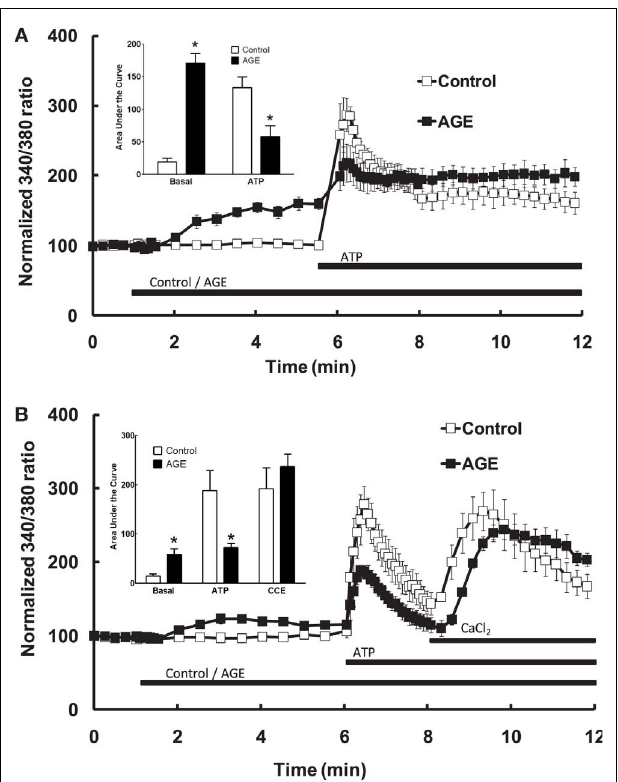
FIGURE 4 | Effect ofAGEs on Ca 2 + signaling in BAEC. (A) In the absence of extracellular Ca 2 + , AGEs alone induced an increase in [Ca 2 + ] and induced significant CCE compared with control (unglycated BSA). (B) In the absence of extracellular Ca 2 + , AGEs added to the BAEC after ATP did not induce an increase in [Ca 2 + ], but increased CCE (CaCl 2 ). Points and columns represent the mean ± SEM of six recordings. *Indicates significant effect of AGEs compared to control ( P < 0.05, t